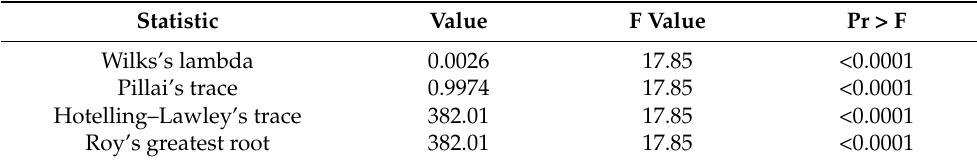
Table 3. The MANOVA results regarding the classification criteria. Statistic